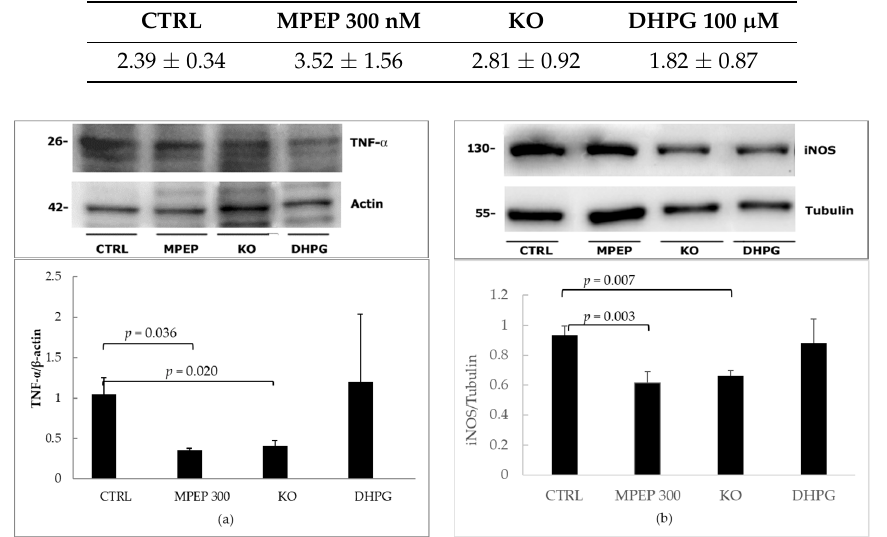
Table 1. ATP measured in liver extracts at the end of 1 h reperfusion (nmol/mg proteins). No significant difference was found among groups (ANOVA).